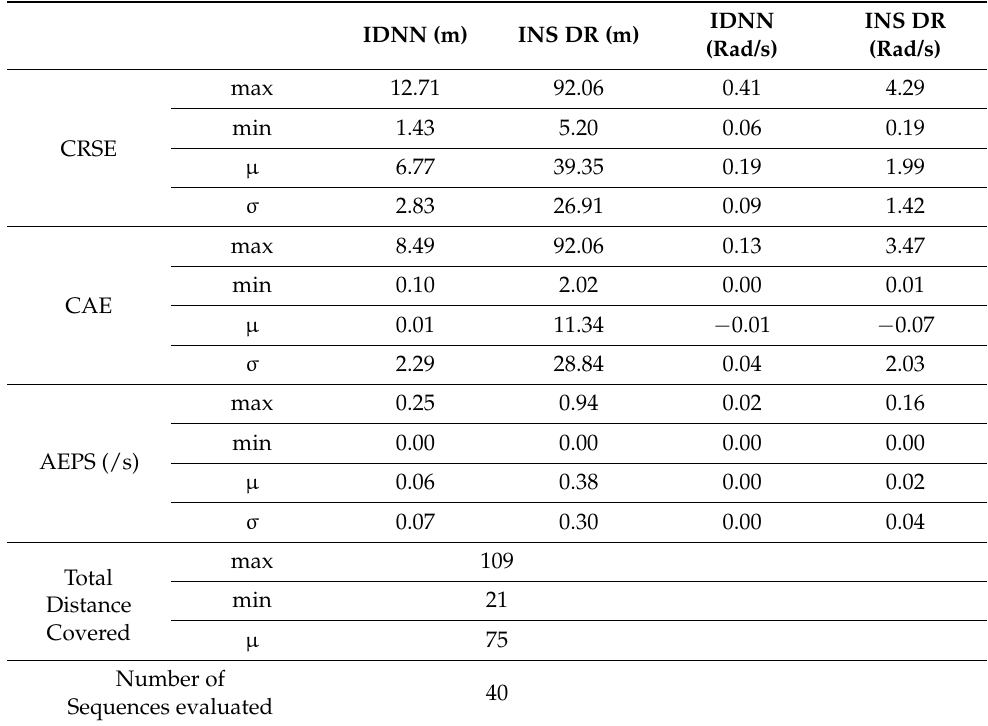
Table 13. Showing the performance of the IDNN and INS DR on the sharp cornering and successive left and right turns